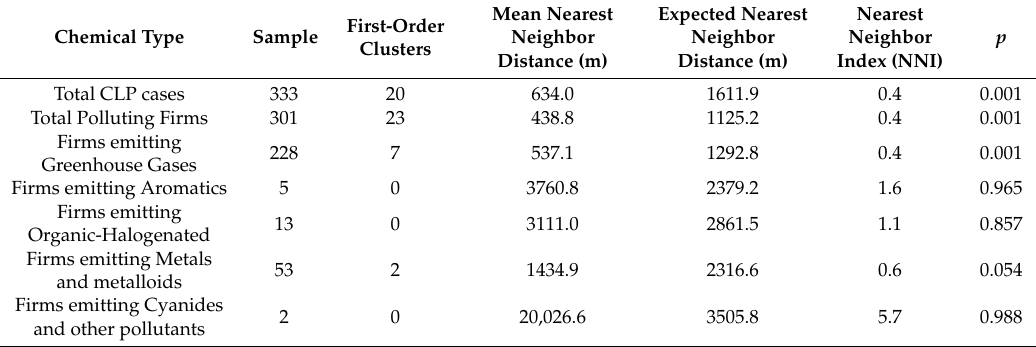
Table 4. Nearest Neighbor Index (NNI) for CLP cases and emitting industry by type of